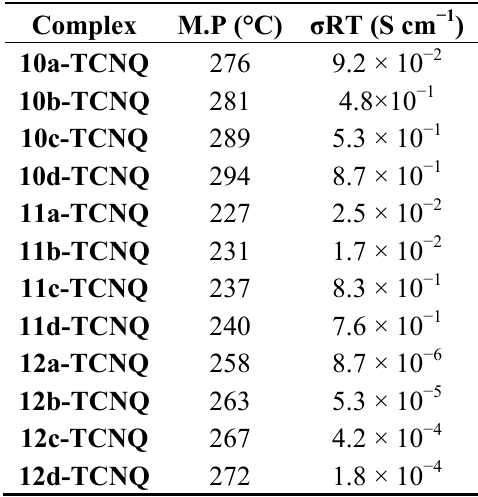
Table 3. Melting points and electrical conductivity of charge transfer